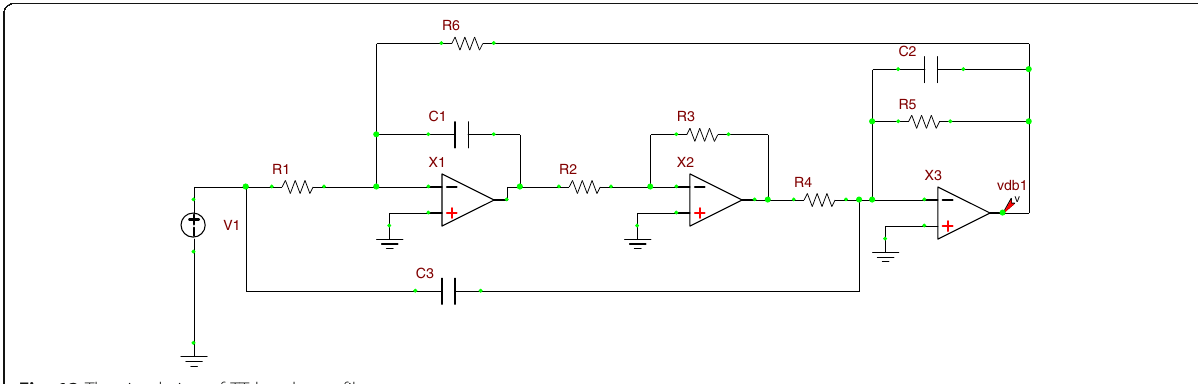
Fig. 12 The simulation of TT band-stop